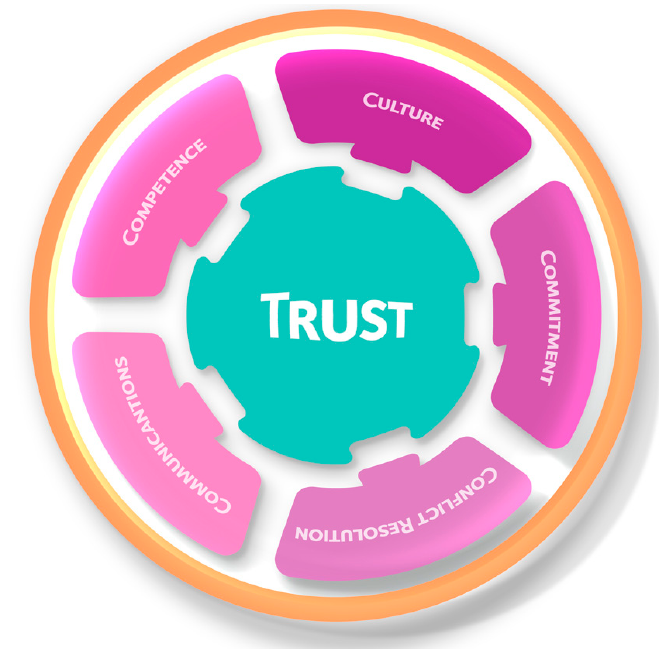
Figure 1. Trust Framework for Research Services/Tools.